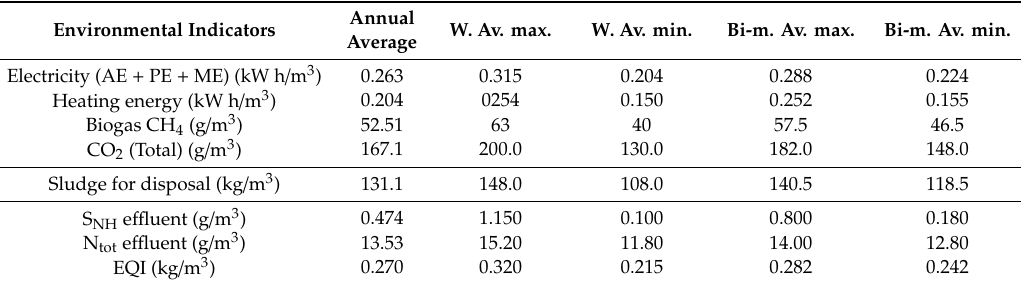
Table 5. Maximum and minimum values in the weekly and bimonthly profile, and average values of environmental indicators with respect to the volume of treated wastewater with DO control scheme (W. Av.: Weekly average, Bi-m Av.: Bimonthly average). W. Av. max.